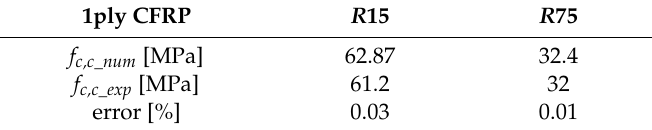
Figure 11. Typical failure mode R 15: ( a ) tensile rupture of fibers and ( b ) damage inside the resin.